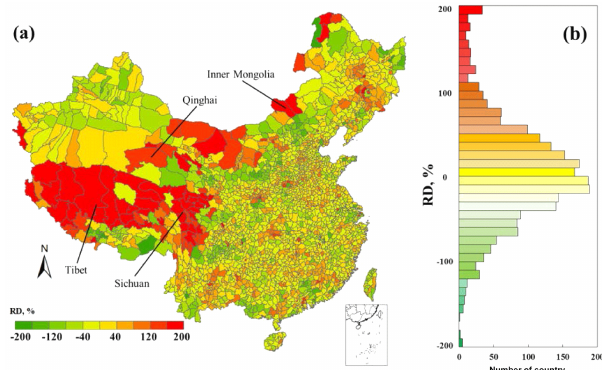
Figure 3. Geographic (a) and frequency (b) distributions of RDs of total NH 3 emissions in 2008 between CAF_NH 3 and PRO-NH 3 . RD = (E 1 − E 2 )/((E 1 + E 2 )/ 2), where E 1 and E 2 are the E total for agricultural fertilizer of the counties for CAF_NH 3 and for PRO- NH 3 for each county, respectively. A negative (positive) RD sug- gests an overestimation (underestimation) of a county’s emissions by utilizing the provincial disaggregation approach (PRO-NH 3 )